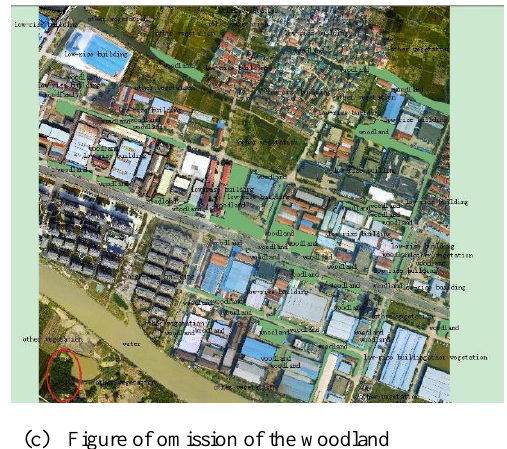
(b)Figure of the buildings colored by elevation value